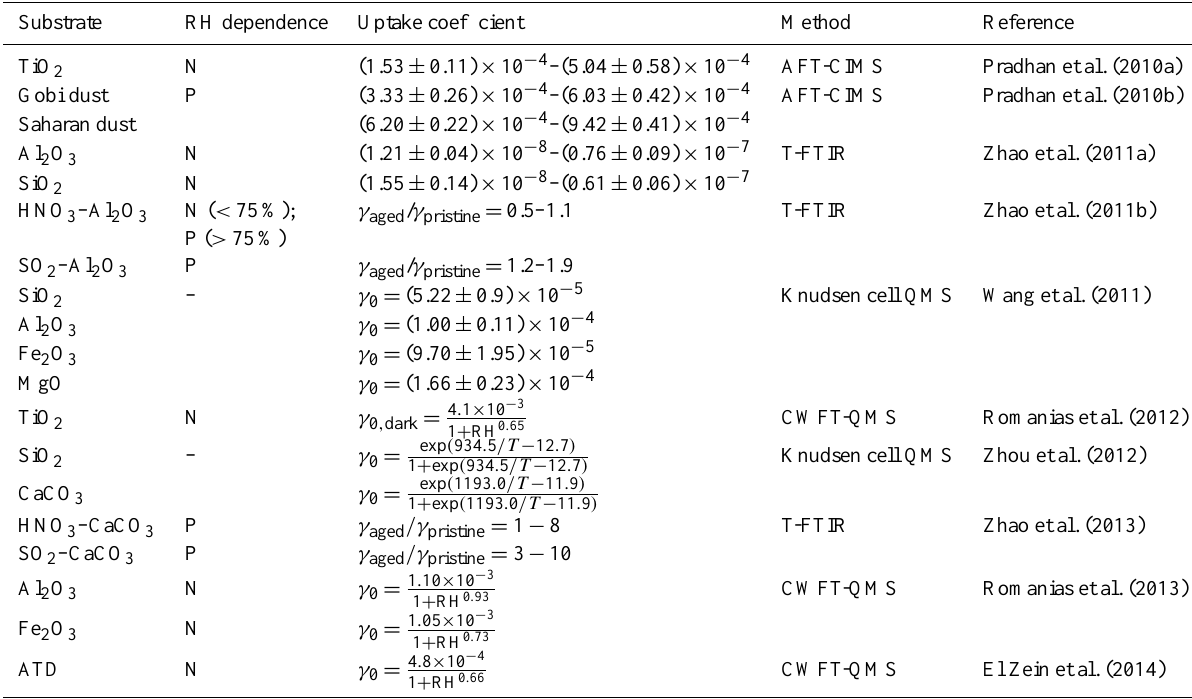
Table 4. Summary of the uptake coefficients of H 2 O 2 on mineral dust particles in literature data. Substrate RH